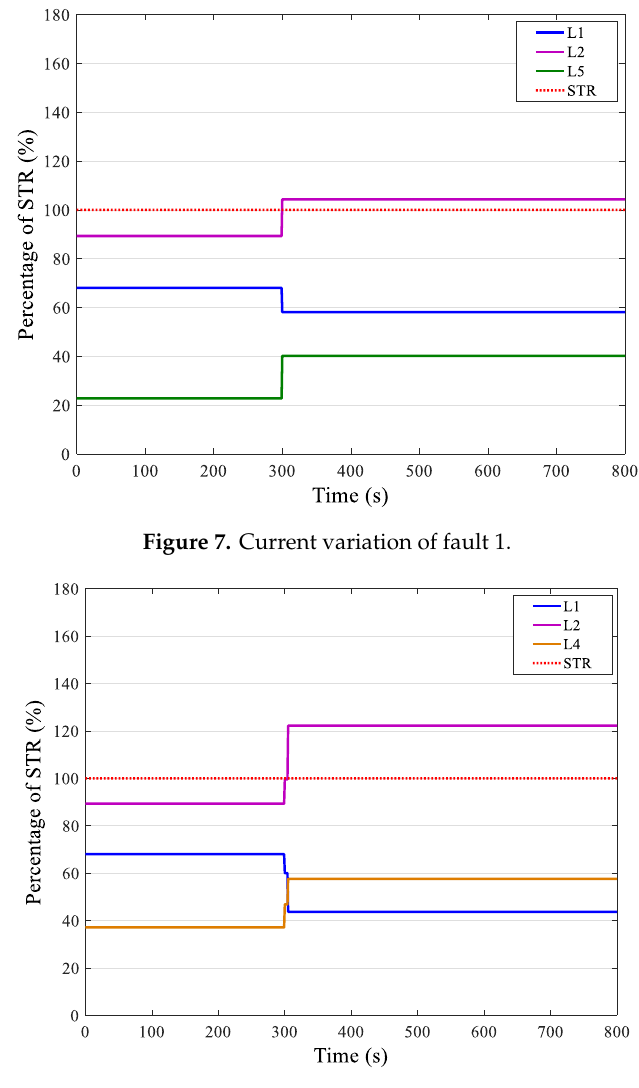
Figure 8. Current variation of fault 2.